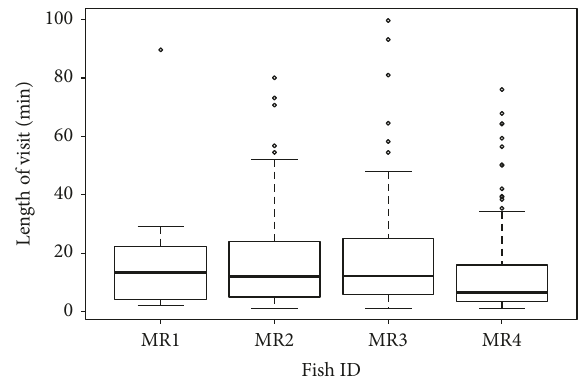
Figure 6: Length of M. ramsayi visits to PVR by each individual. Boxplots show medians and interquartile range, with whiskers denoting upper and lower quartiles. Open circles denote outliers. Note that single detections were removed from the analysis on the assumption that these corresponded to fish passing through the range of the